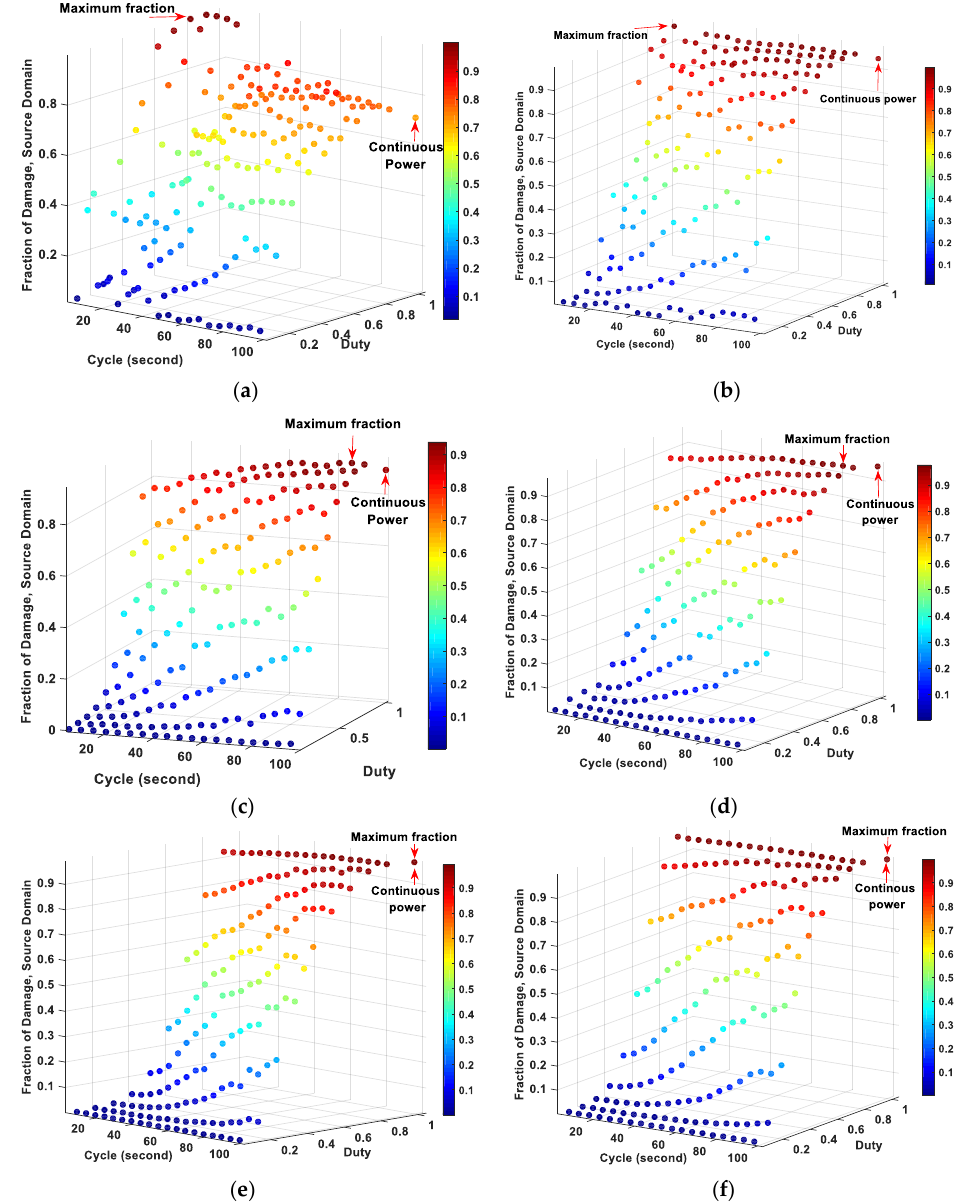
Figure 1. Fraction of tissue damage at source domain by changing source diameter: ( a ) 1 mm, ( b ) 2